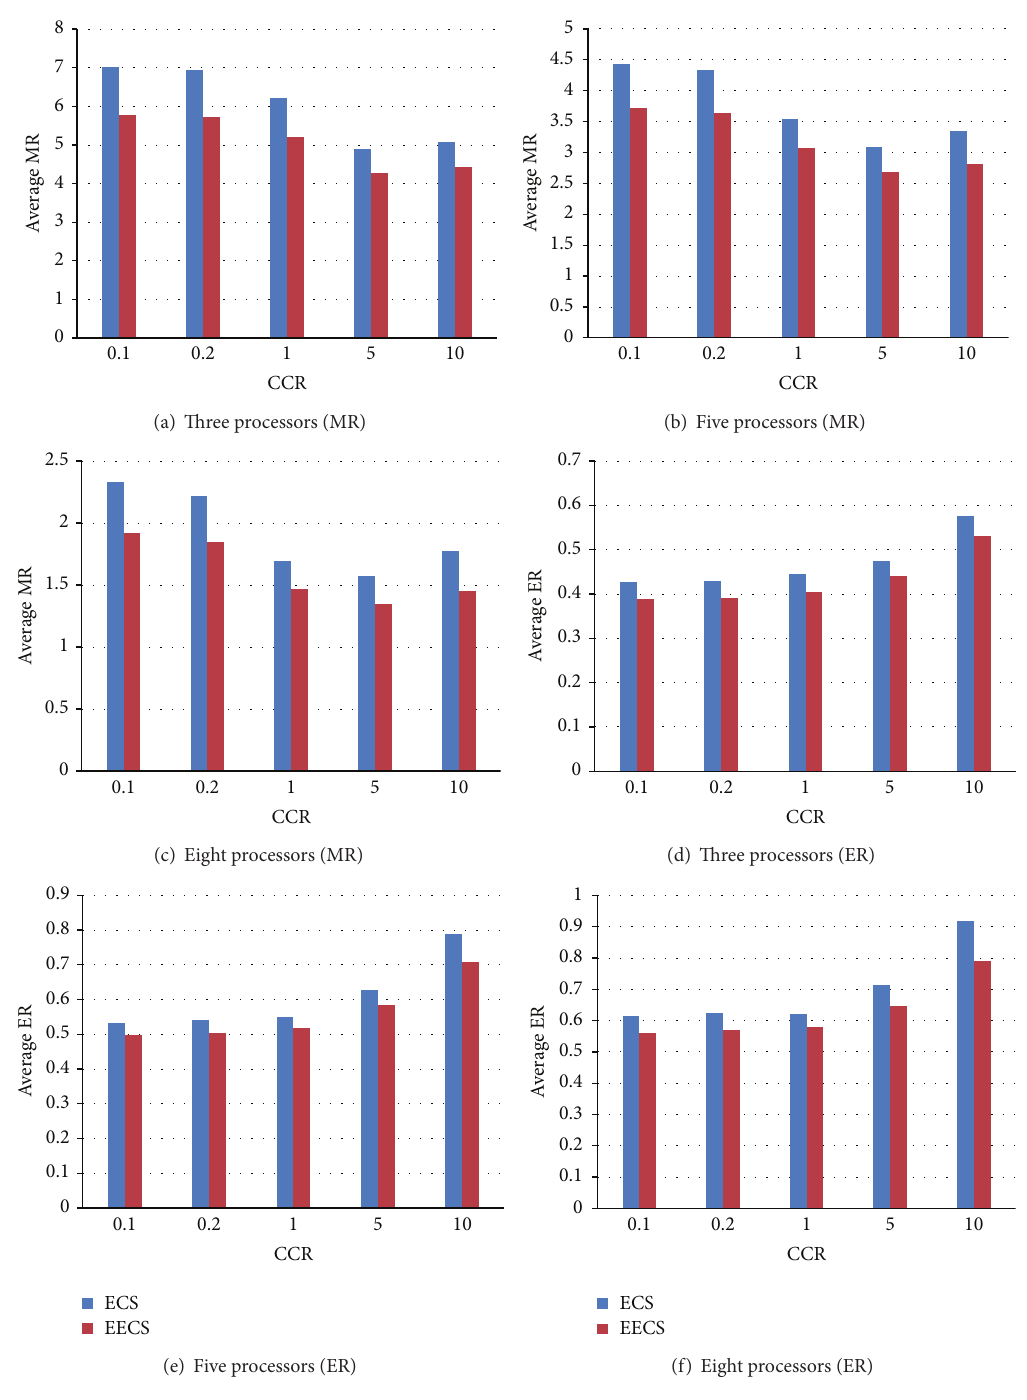
Figure 4: Laplace, 49 nodes (different sizes of